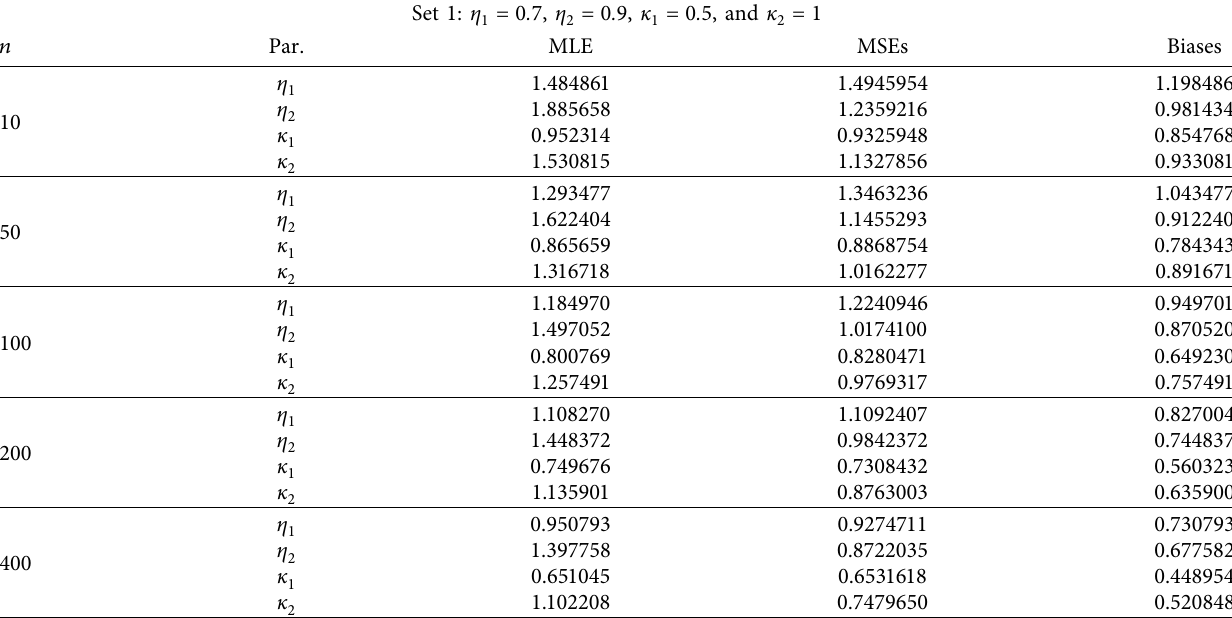
Table 2: Simulation results of the ASNFEW distribution for the second set of parameter